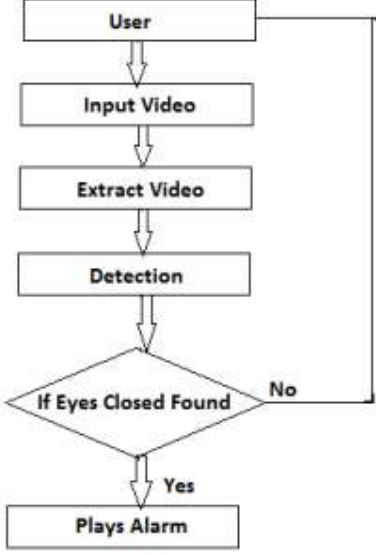
Figure 3: Flow of Operation